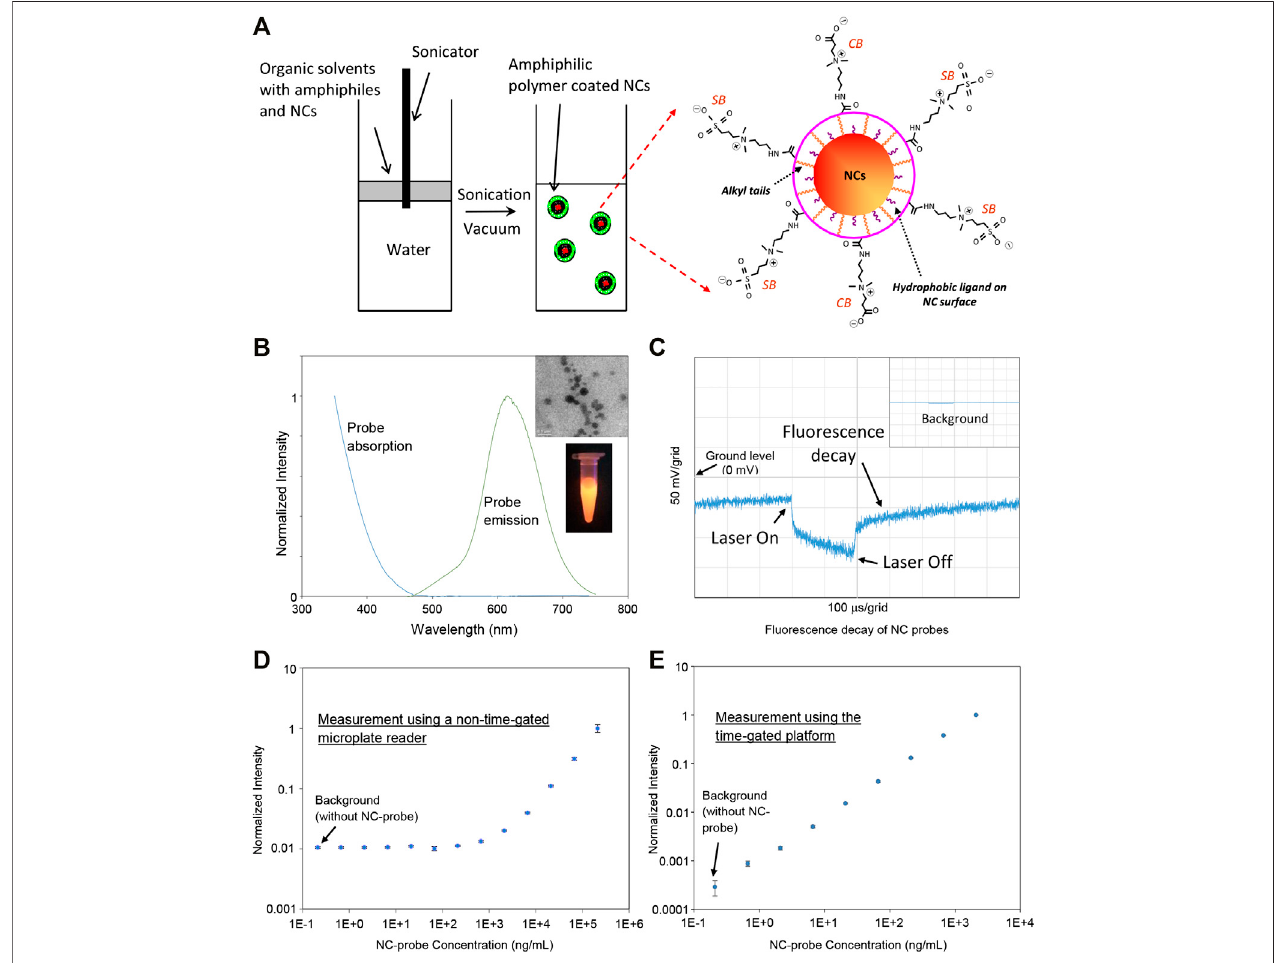
FIGURE 2 | (A) Illustration on the preparation method of NC probes for immunoassay. (B) The fl uorescence and absorption spectra of the NC probes. The inset images present a representative TEM image of the prepared NC probes and their emission under UV light. (C) Representative fl uorescence decay of the NC probes dilutedinpurewater — theNCprobesemit fl uorescenceafterlaser-off.Theinsetpresentsthebackgroundforpurewater. (D) CalibrationcurveoftheNCprobesinwater (with5%BSAmimickingahighauto fl uorescentsamplematrix)measuredusinganongatedmicroplate reader. (E) CalibrationcurveoftheNCprobesinwater(with 5% BSA) measured using the time-gated